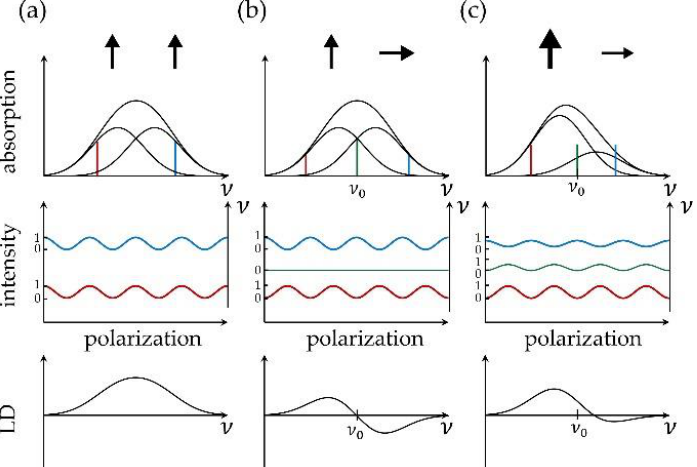
Figure 1. Each column ( a – c ) shows from top to bottom a schematic sketch of an absorption spectrum, the normalized intensity modulation as a function of the polarization for distinct spectral components, and the resulting LD spectrum. For illustration, a few transition frequencies (blue, green, red) have been indicated. The illustrations refer to perfectly oriented samples that feature ( a ) two transitions with different energies and parallel transition-dipole moments; ( b ) two transitions with different energies and mutually orthogonal transition-dipole moments of equal magnitude; ( c ) two transitions with different energies and mutually orthogonal transition-dipole moments of non-equal magnitude.